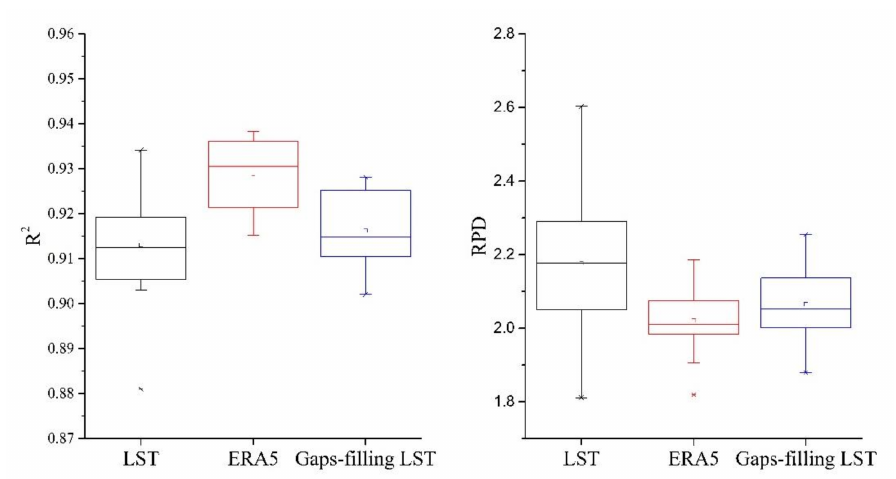
Figure 5. Comparison of air temperature with raw MODIS LST (black), surface temperature derived from ERA5 climate reanalysis data (red), and gaps-filling MODIS LST (blue), from 2001 to